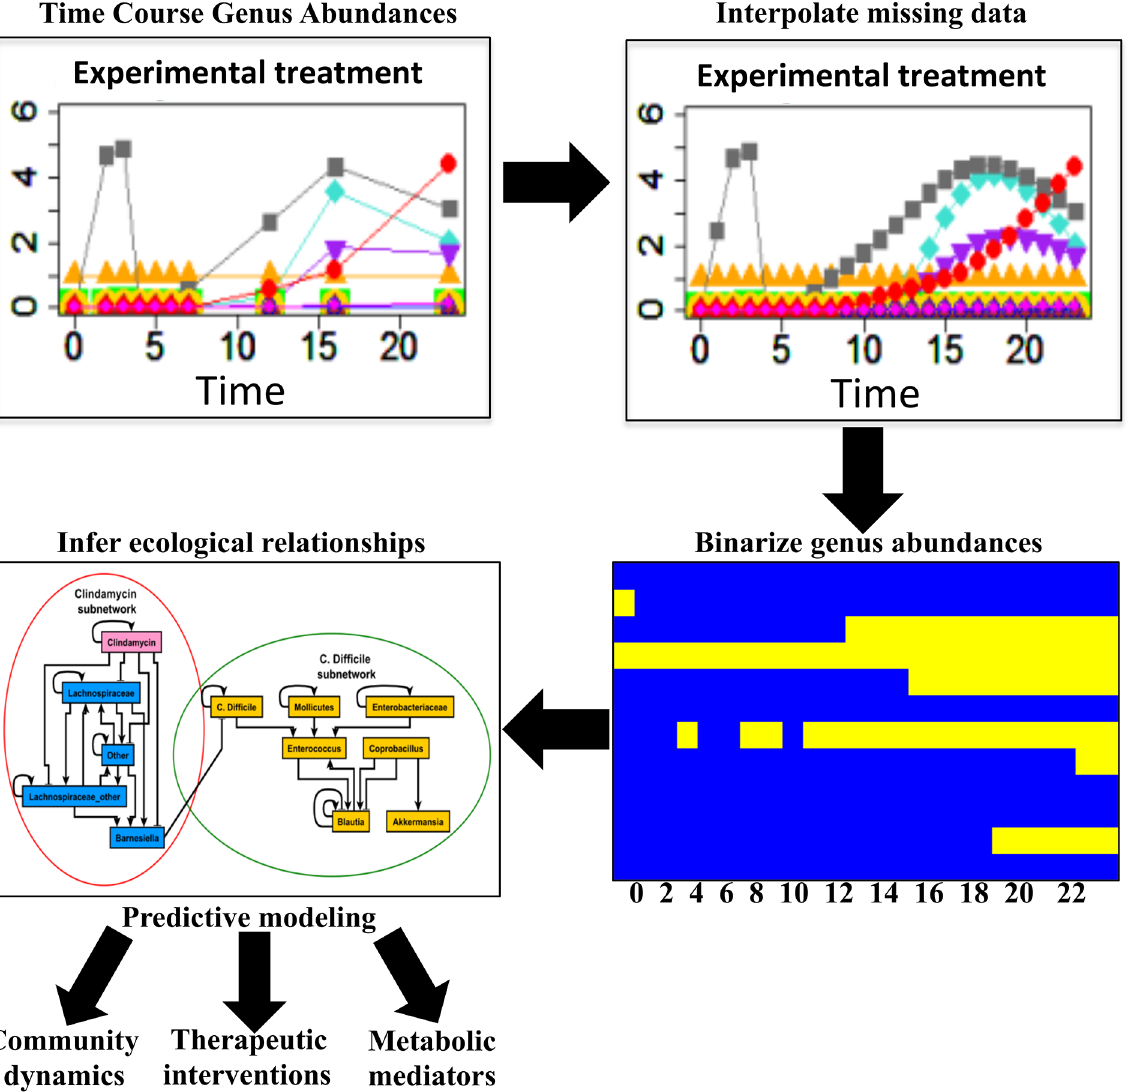
Fig 1. Dynamic analysis workflow. Time course genus abundance information was acquired from metagenomic sequencing of mouse gastrointestinal tracts under varying experimental conditions. Missing time points from experimental data were estimated such that genus abundances existed at the same time points across all treatment groups. Next, genus abundances were binarized such that Boolean regulatory relationships could be inferred. A dynamic Boolean model was constructed to explore gut microbial dynamics, therapeutic interventions, and metabolic mediators of bacterial regulatory relationships.